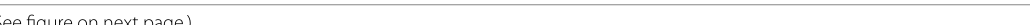
Figure 2b–d show an example of the 3D CMT inver- sion. The optimal solution for an earthquake on June 8, 2017 is a low-angle (22°) thrust faulting at a depth of 48 km, deeper the upper surface (40 km) and close to the oceanic Moho (48 km) of the Pacific Plate. The figure on next Fig. 2 Settings and an example of 3D CMT inversion in the Kanto region. a Simulation settings to evaluate Green’s functions. The regions enclosed by the blue dashed and red dotted lines represent the horizontal coverage of the simulation model regions for evaluating Green’s functions and long-period ground motion simulations, respectively. The triangles and crosses in the map denote the locations of the F-net stations and the assumed source grids, respectively. ( b–d ) an example of a CMT solution for an earthquake on June 8, 2017, the location and depth of the optimal solution, used stations, and depth variations of optimal solutions at each source grid. Colors of the focal mechanisms reflect values of variance reduction between observed and synthetic displacements in the 25–100 s period band. The numbers above the optimal solutions in ( b ) are the optimal centroid depths. The grey focal mechanism in ( b ) is the F-net MT solution of this earthquake. The blue triangles in ( b ) are used F-net stations. ( c ) Spatial variations of VRs along latitude-depth and longitude-depth planes. ( d ) Examples of comparisons between observed and synthetic displacements in the 25–100 s period band. Gray solid and blue dotted lines are the observed and synthetic seismograms, respectively. Synthetic seismograms were evaluated by assuming the optimal solution. Amplitudes at each station were normalized by the maximum amplitude of observed and synthetic three-component displacement